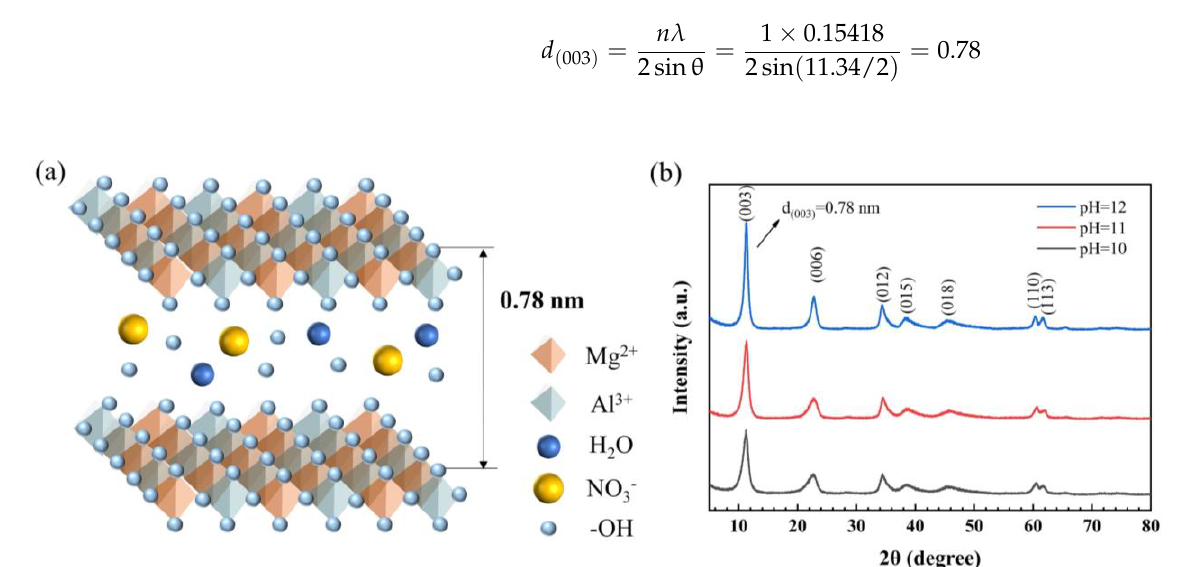
Figure 1. The schematic diagram ( a ) and XRD patterns ( b ) of MgAl-LDH prepared with various pH.